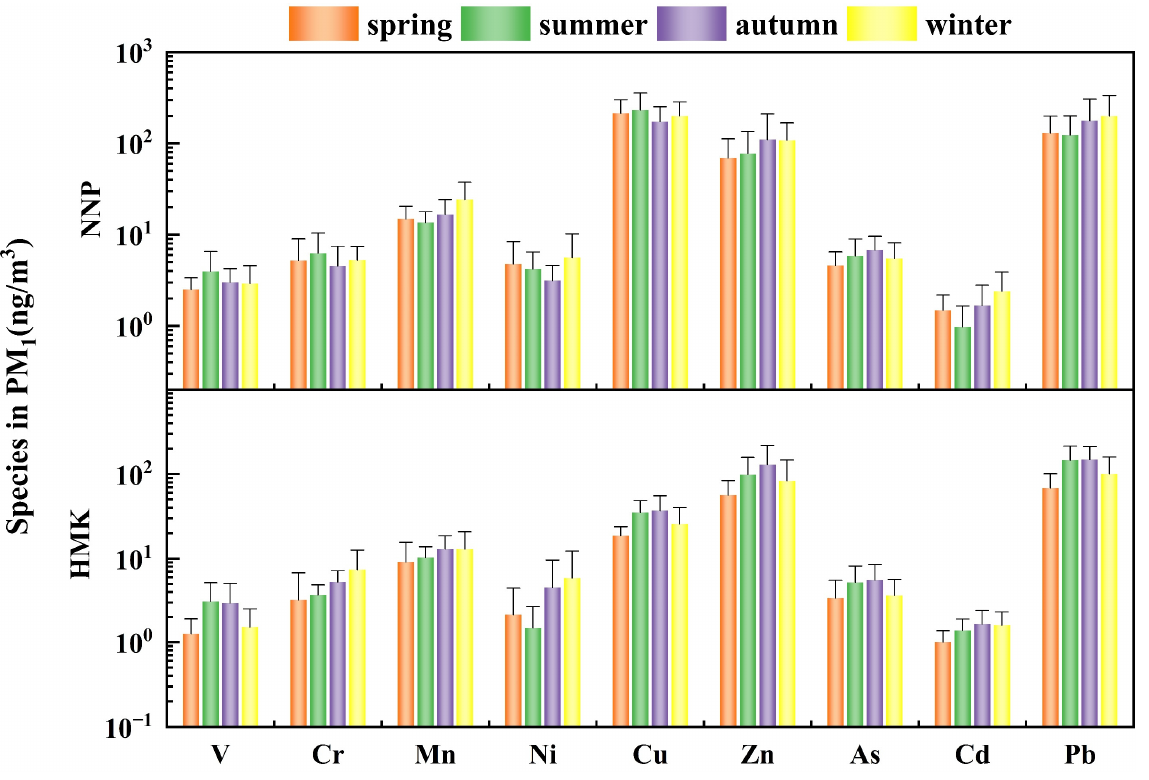
Figure 6. Seasonal distribution characteristics of PTEs in PM 1 .